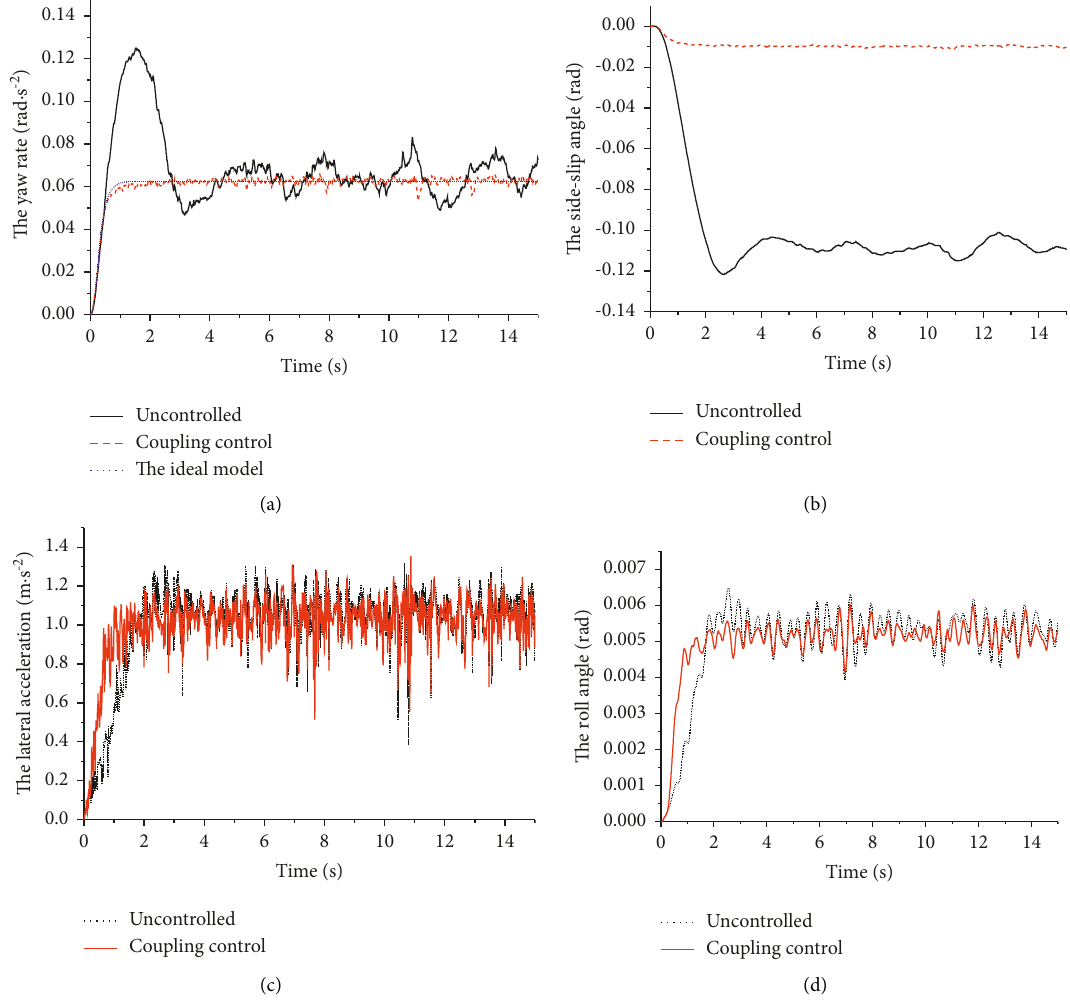
Figure 13: Handling stability control result under angular step. (a) Yaw rate. (b) Side-slip angle. (c) Lateral acceleration. (d) Roll